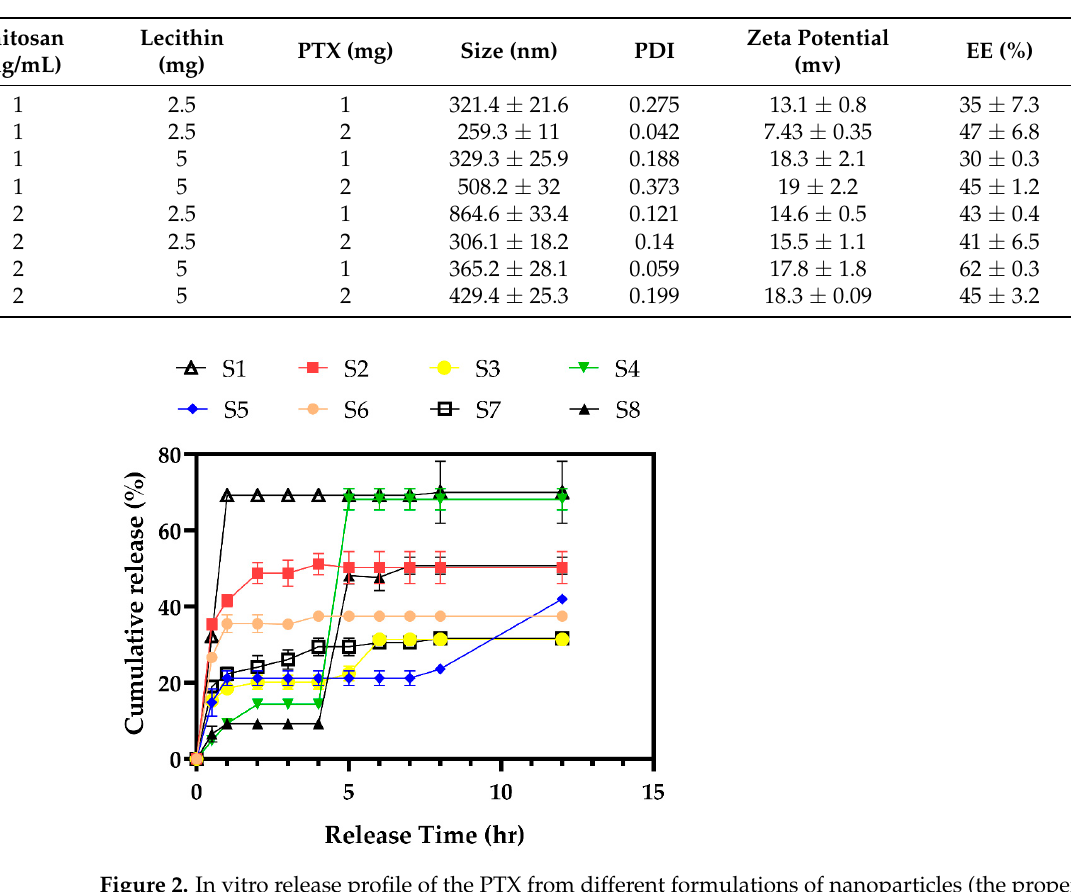
Figure 2. In vitro release profile of the PTX from different formulations of nanoparticles (the properties of nanoparticles and their formulations are summarized in Table 1). ties of nanoparticles and their formulations are summarized in Table